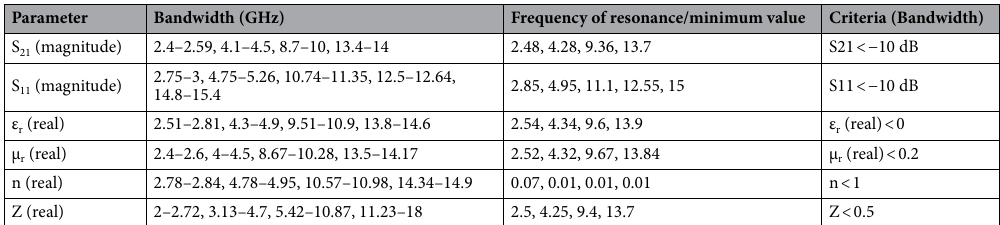
Table 3. Extracted data for different properties of the proposed MTM unit cell.